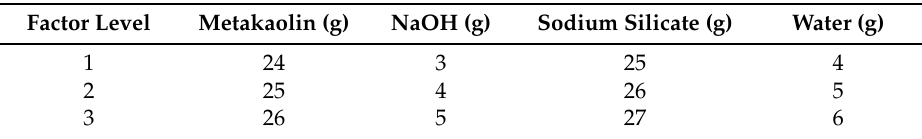
Table 3. Factor level of orthogonal experiment